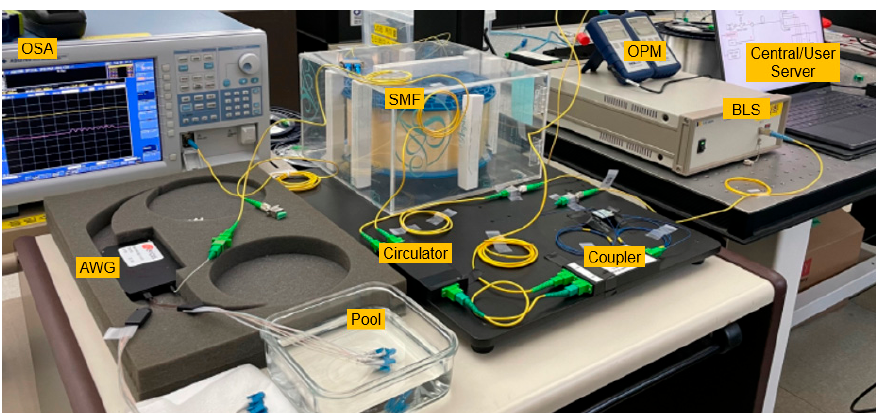
Figure 4. Experimental setup for demonstration of the passive IoT-based optical fiber sensor network with water level monitoring.